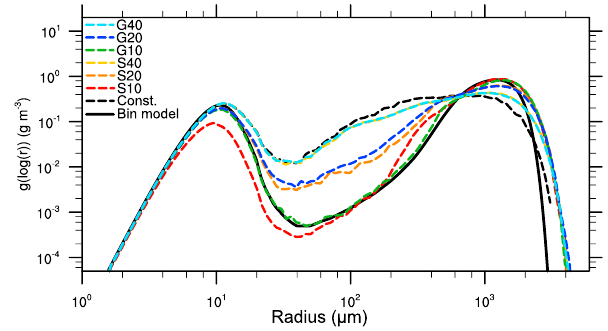
Figure 7. Same as Fig. 3 but for the multi-box approach, i.e., inter- actions between the grid boxes are possible.